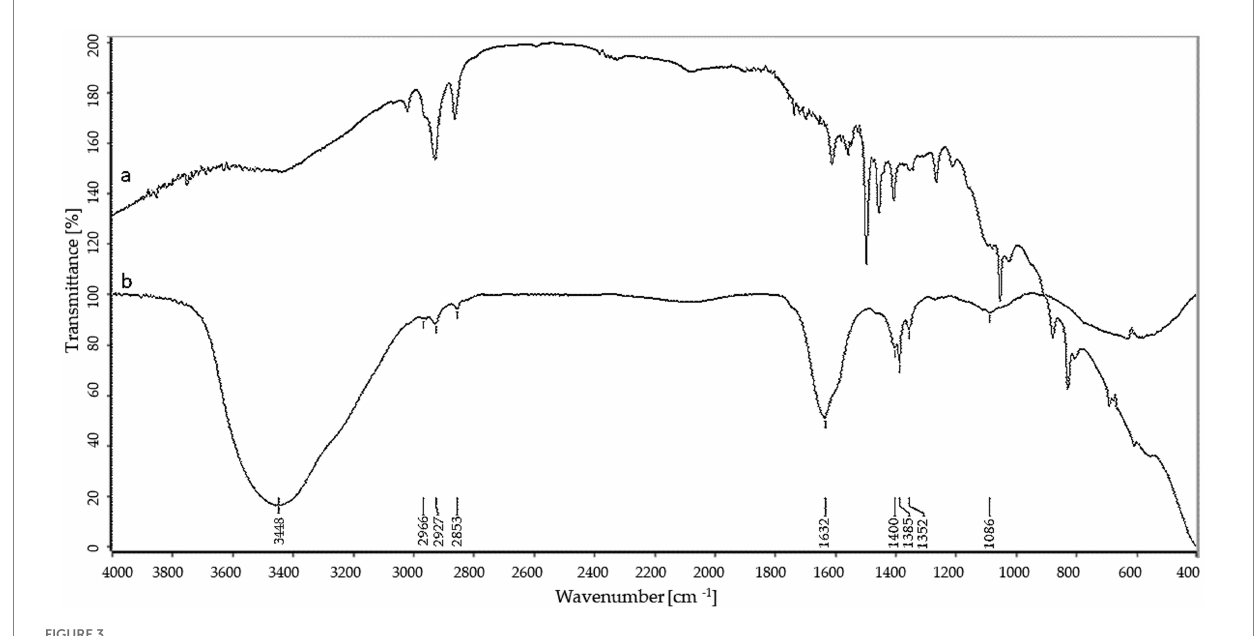
FIGURE 3 FTIR spectra of control (a) and silver nanoparticles (b).